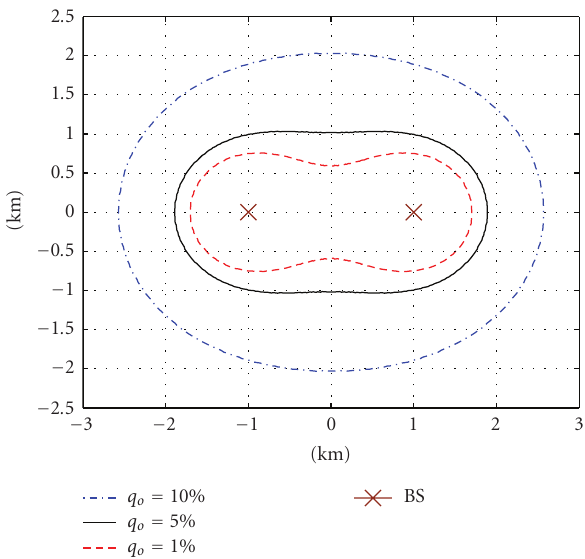
Figure 4: MISO with antenna location (1,0) and ( − 1,0).